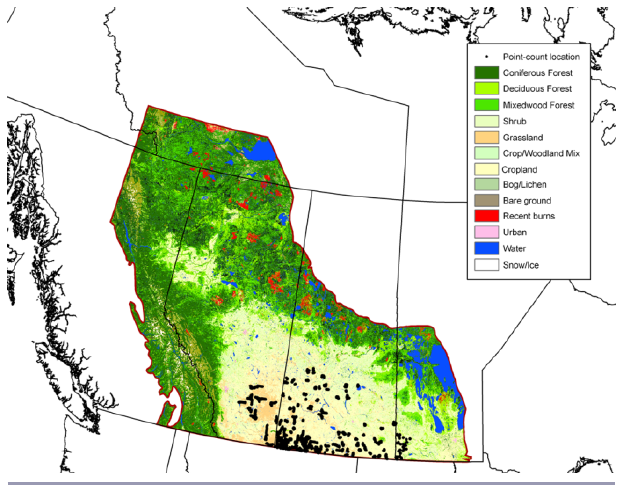
Fig. 1 . Geographic distribution of the Western Canadian Sedimentary Basin (WCSB), and point-count sampling of grassland bird abundance (see Methods). Land cover derived from Latifovic et al.